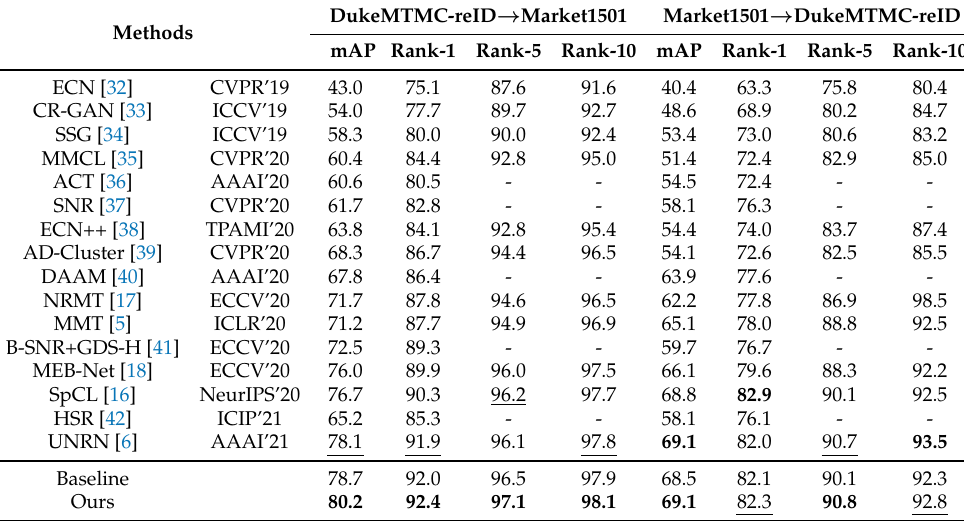
Table 4. The performance of different models evaluated on cross-domain datasets. Market1501 → DukeMTMC-reID means that we trained the model on the Market1501 and evaluated it on the